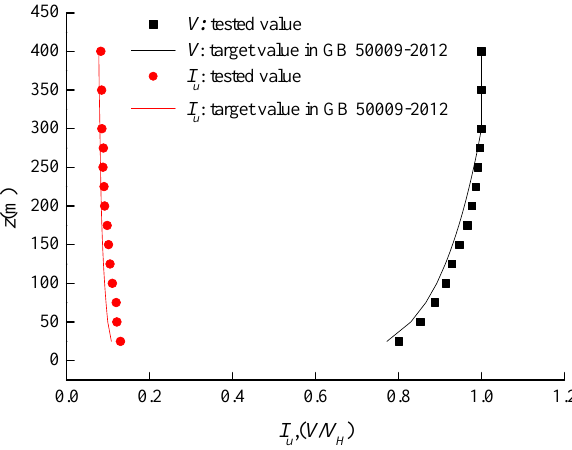
Figure 3. Mean wind speed and turbulent intensity.